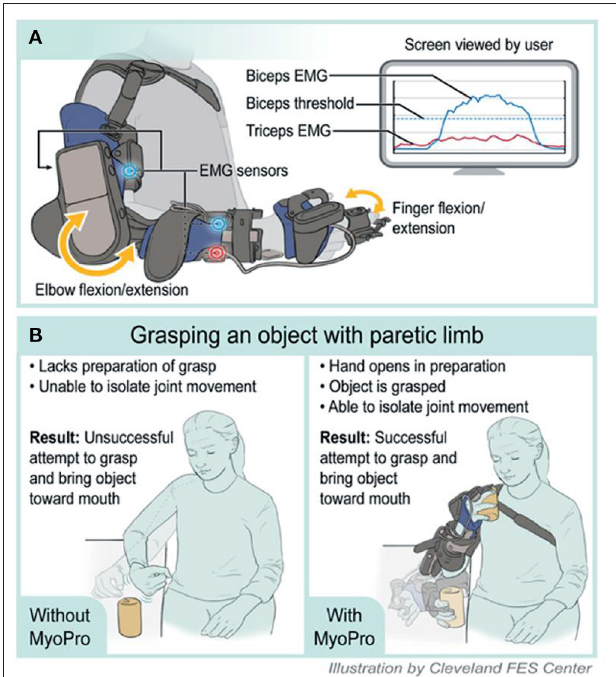
FIGURE 2 | Illustration of MyoPro use and implementation in motor learning. (A) Device function. (B) Grasping an object with paretic limb. EMG,